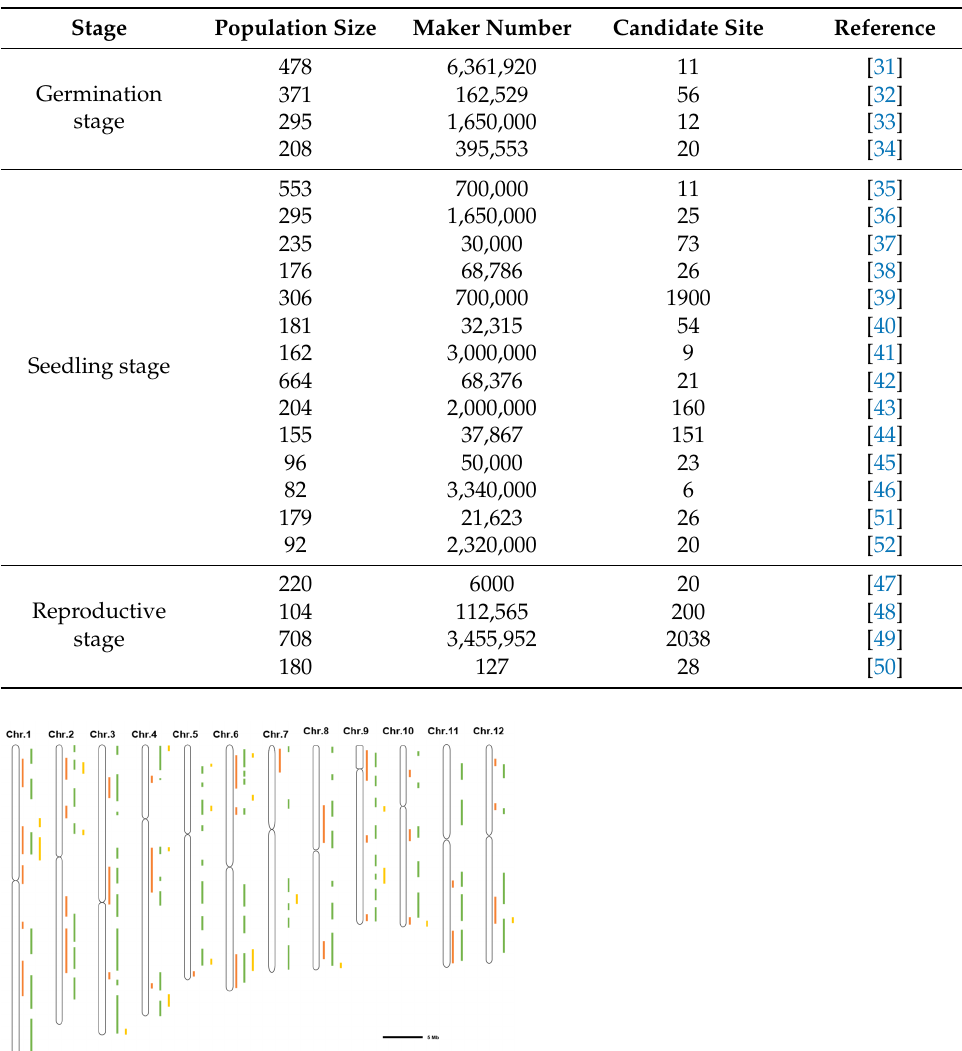
Table 1. Summary of salt stress related loci identified by GWAS.